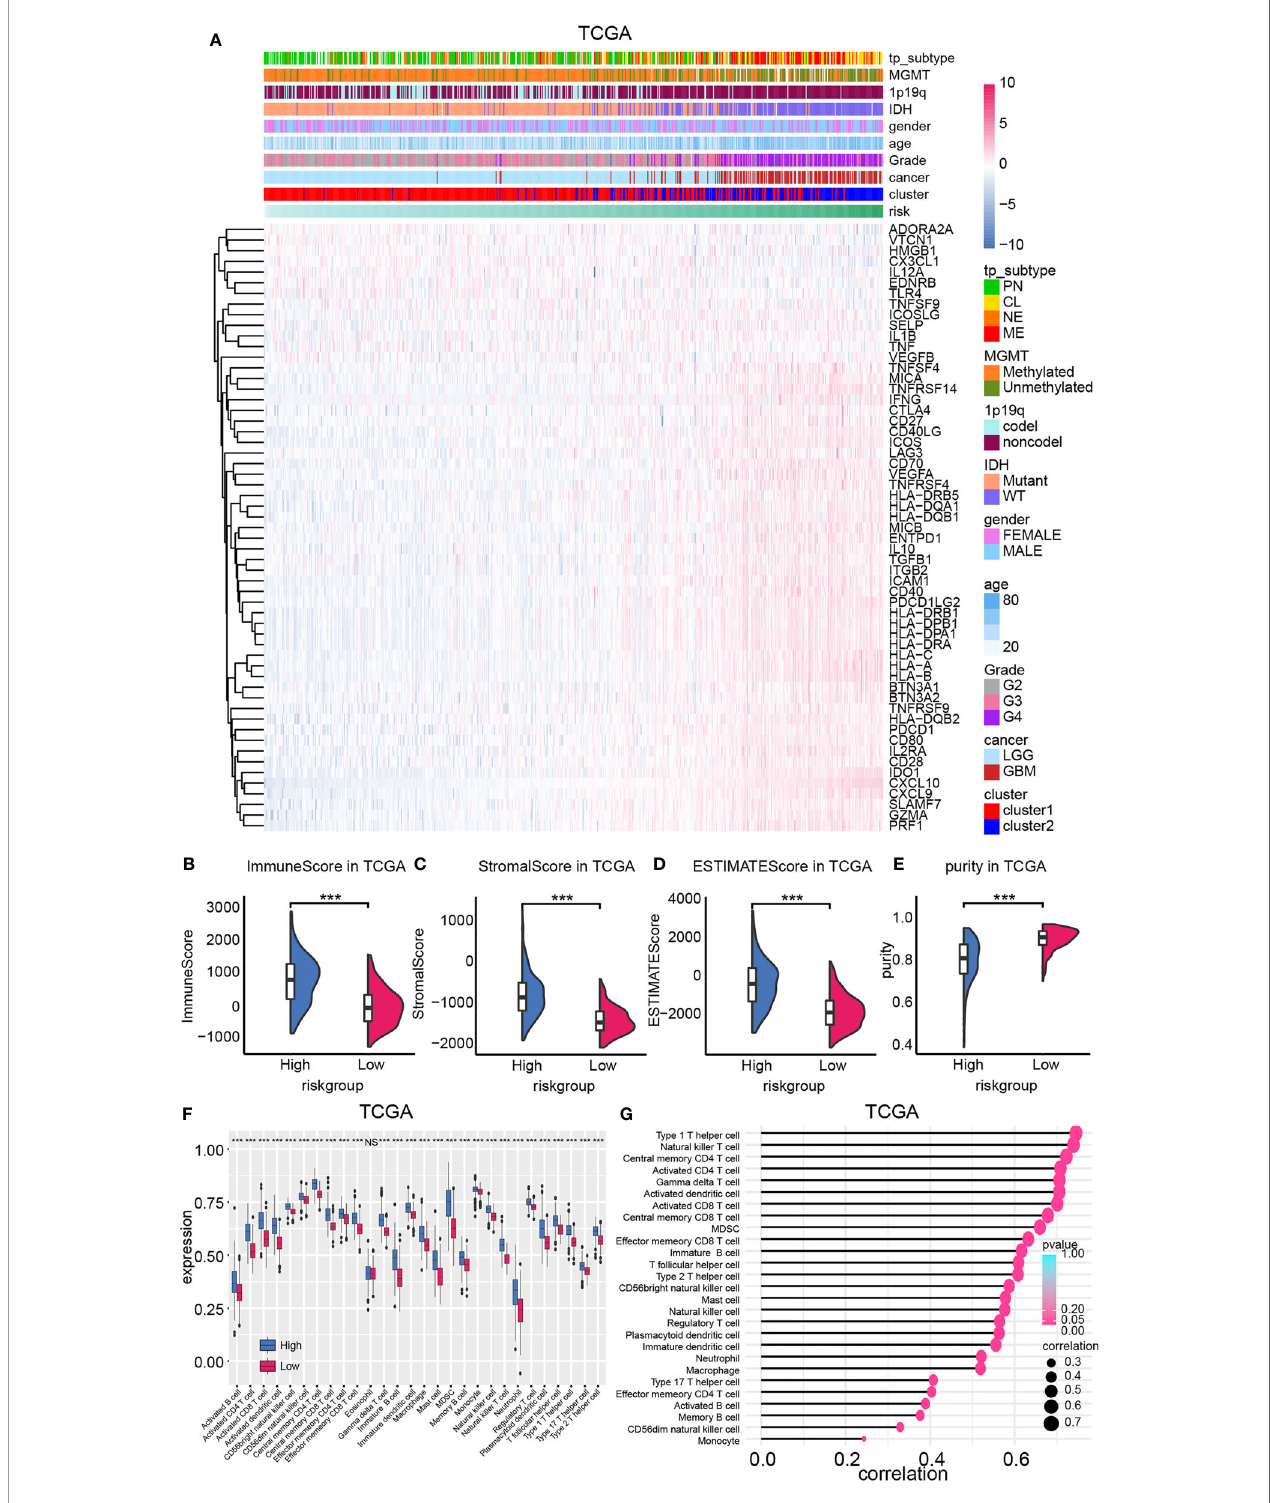
FIGURE 5 | The expression of ICGs and immunocyte in fi ltration ratio. (A) ICG expression was mapped based on the risk model. The ImmuneScore (B) , StromalScore (C) , ESTIMATEscore (D) , and purity (E) difference between high- and low-risk group in TCGA database. (F) Immunocyte in fi ltration ratio enrichment score based on the risk model. (G) The correlation between the enrichment score of immunocytes and the risk model. NS, not signi fi cant, ***p <